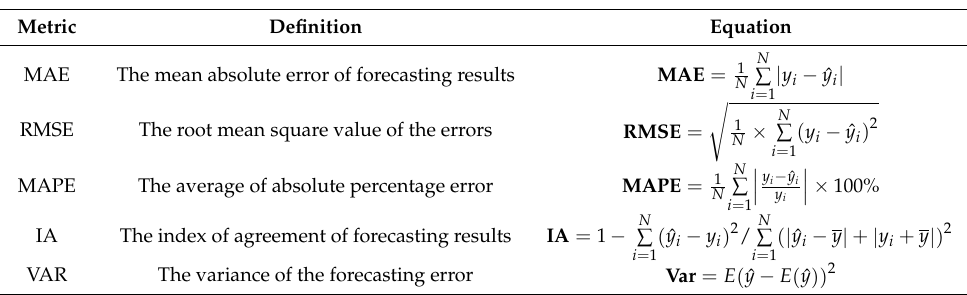
Table 6. Specific definitions of error criteria.